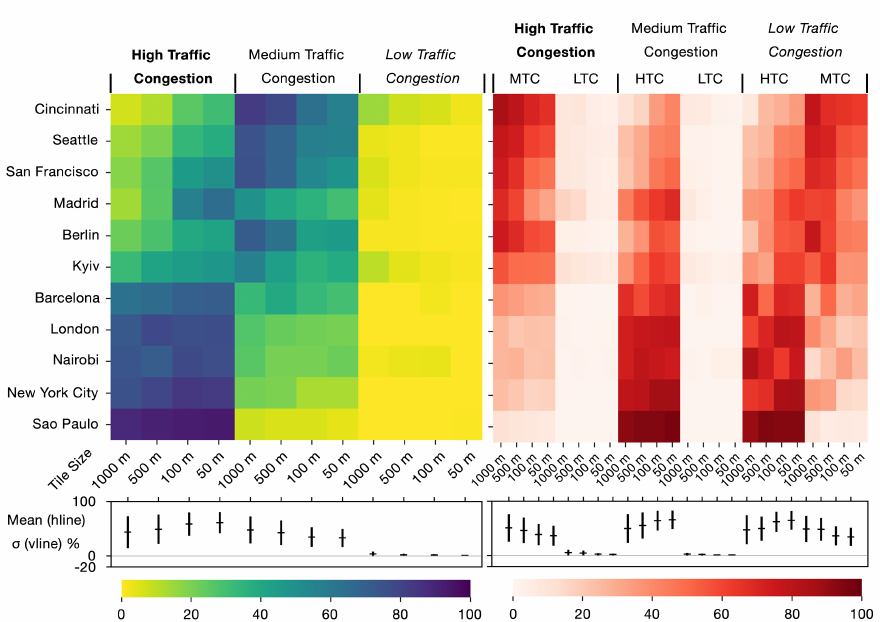
Figure 4. Accuracy of prediction of three traffic classes identified by the betweenness centrality measure, with the Uber Movement classes used as ground truth ( left ). Colours indicate the percentage of tiles correctly classified by the model using the adapted betweenness centrality as predictor. Extent of over/underestimation in wrongly classified classes using this proxy ( right ). Colours indicate the share of tiles incorrectly classified by the model using adapted betweenness centrality as a predictor.